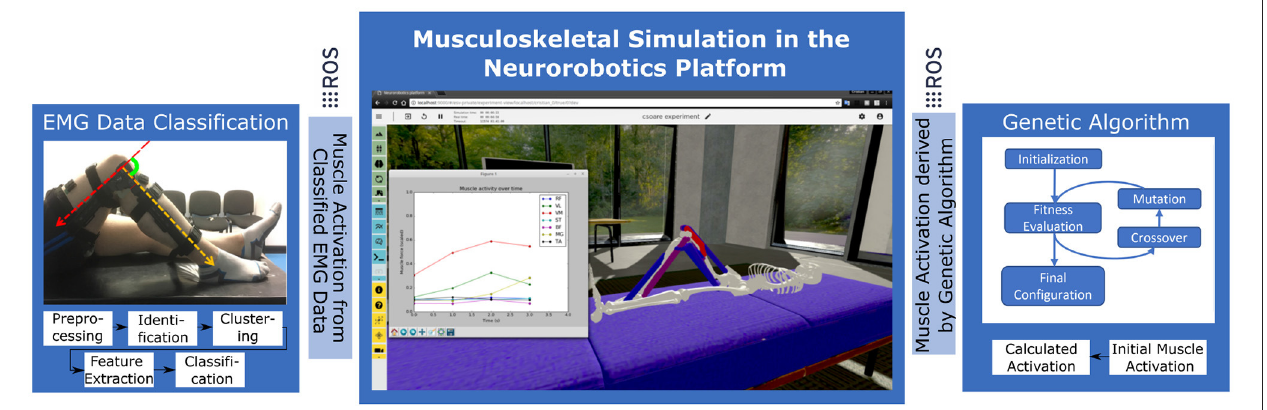
FIGURE 3 | Experiment setup in the Neurorobotics Platform with two distinct control approaches: EMG data from the participant study is processed and applied to the simulated model to record resulting knee forces. In a second step optimal synergies are calculated by Genetic Algorithms using the simulation model as test and evaluation